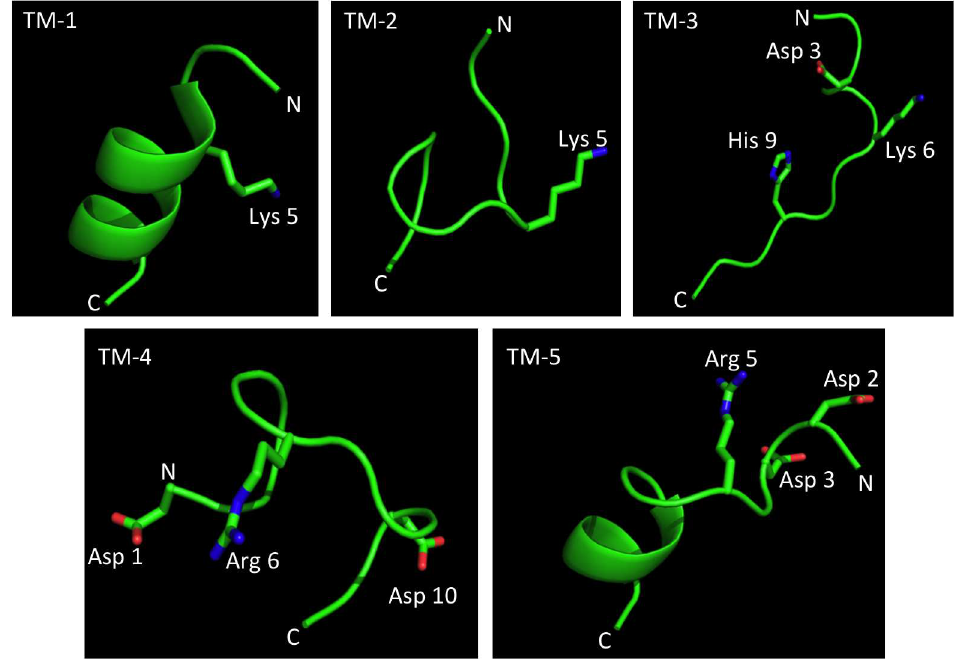
Fig 3. 3-D structural analysis of the five trans-TM peptides. Structures were predicted using Pep-Fold3.0. N = amino-terminus; C = carboxy terminus. Selectedamino acids indicatedby positionrelative to N.